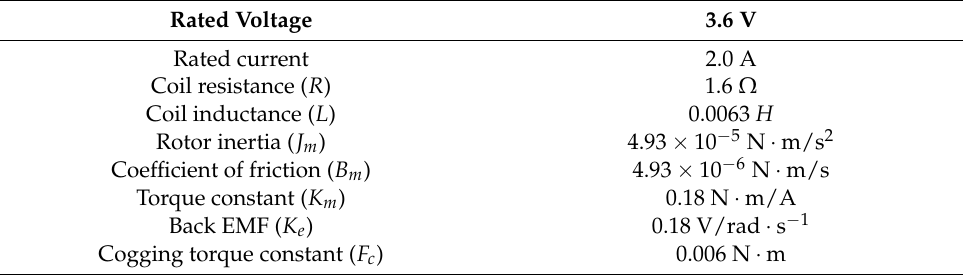
Table 1. The parameters of the simulated motor.